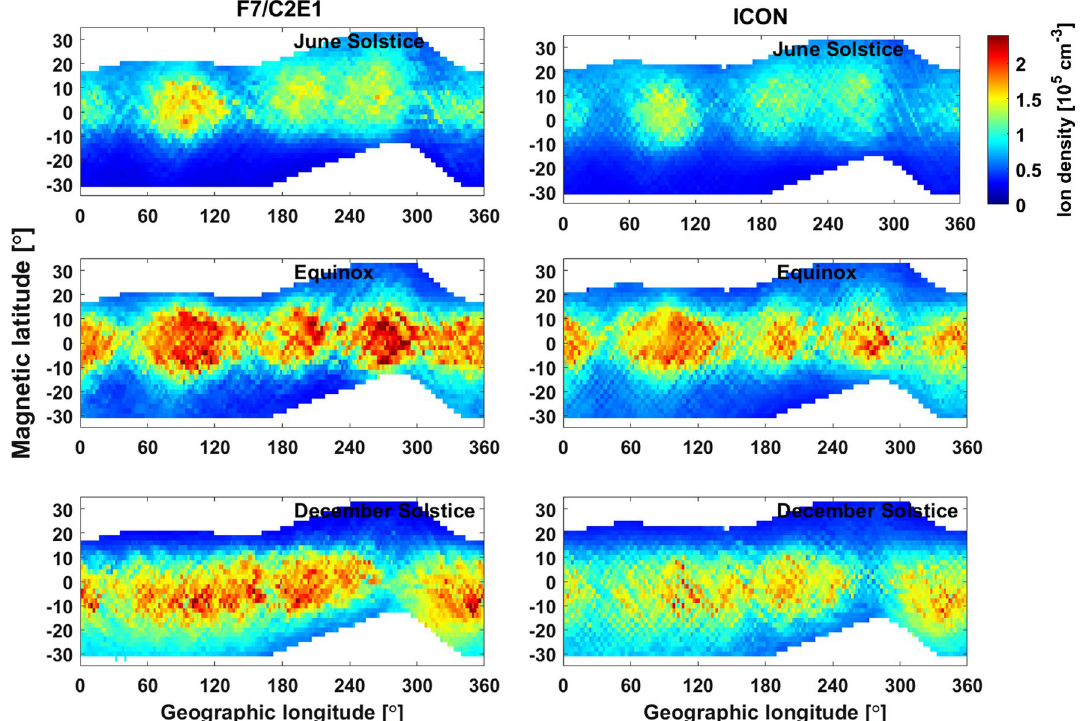
Fig. 6 The longitudinal ion density structures at 12:00–14:00 LT observed from ICON and F7/C2E1 for three